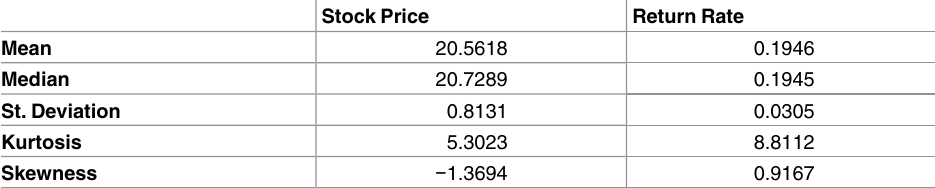
Table 1. Descriptive statistics (different types of agents). Source: Own creation.